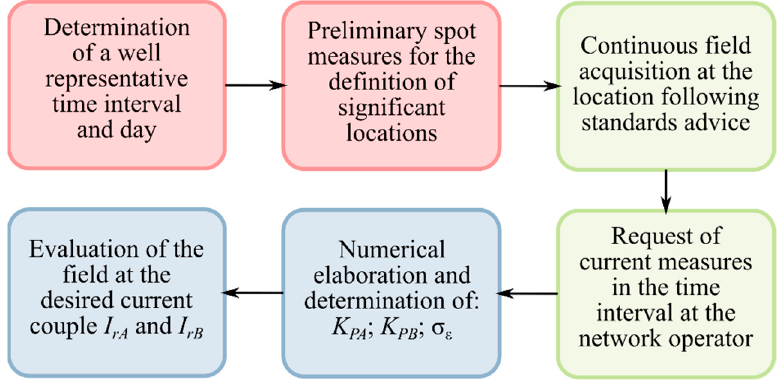
Figure 1. Flowchart of the proposed procedure applied to a double-circuit line—preliminary steps in red, data acquisition in green, and numerical post-processing in blue.